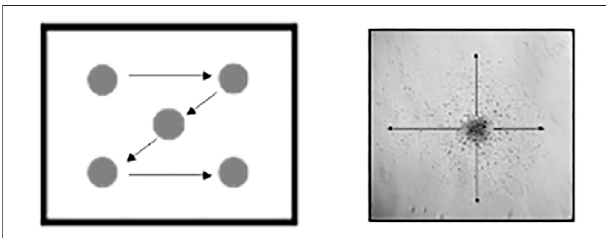
FIGURE 4 | Schematic representation of the direction to follow while taking pictures for migration (left) and of the four distances to measure per sphere in the migration assay